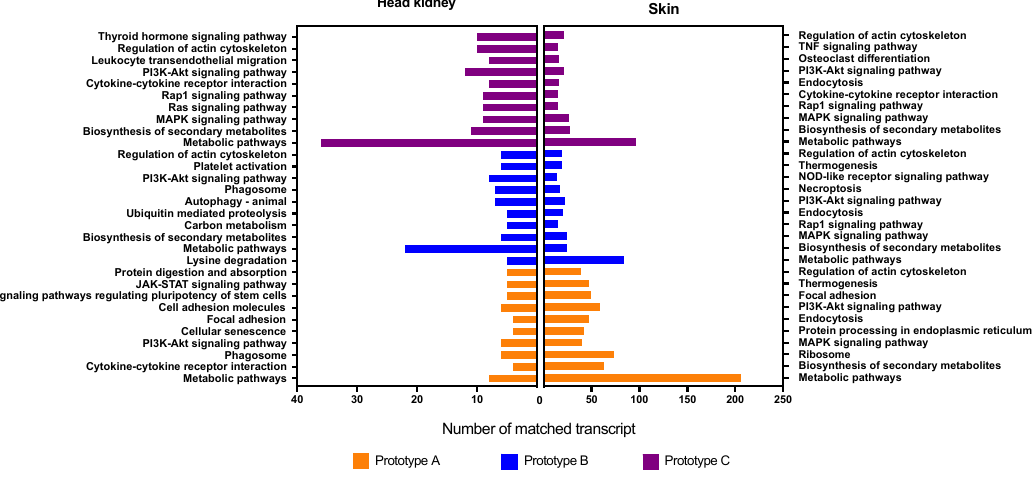
Figure 7. KEGG pathway enrichment analysis of differential expressed contigs. Bars represent the enriched contigs count for the pathway.